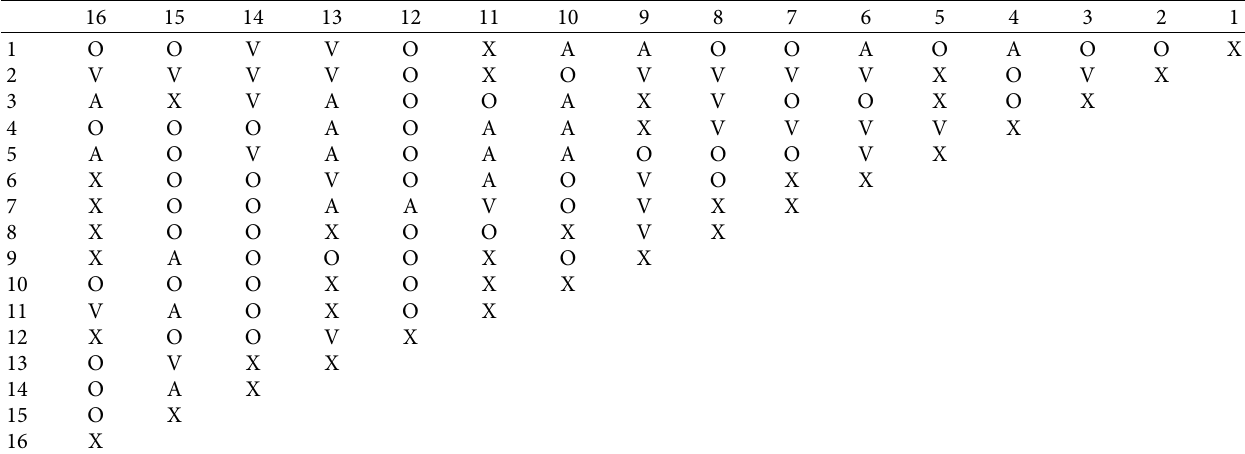
Table 2: Structural selfinteraction matrix (SSIM).